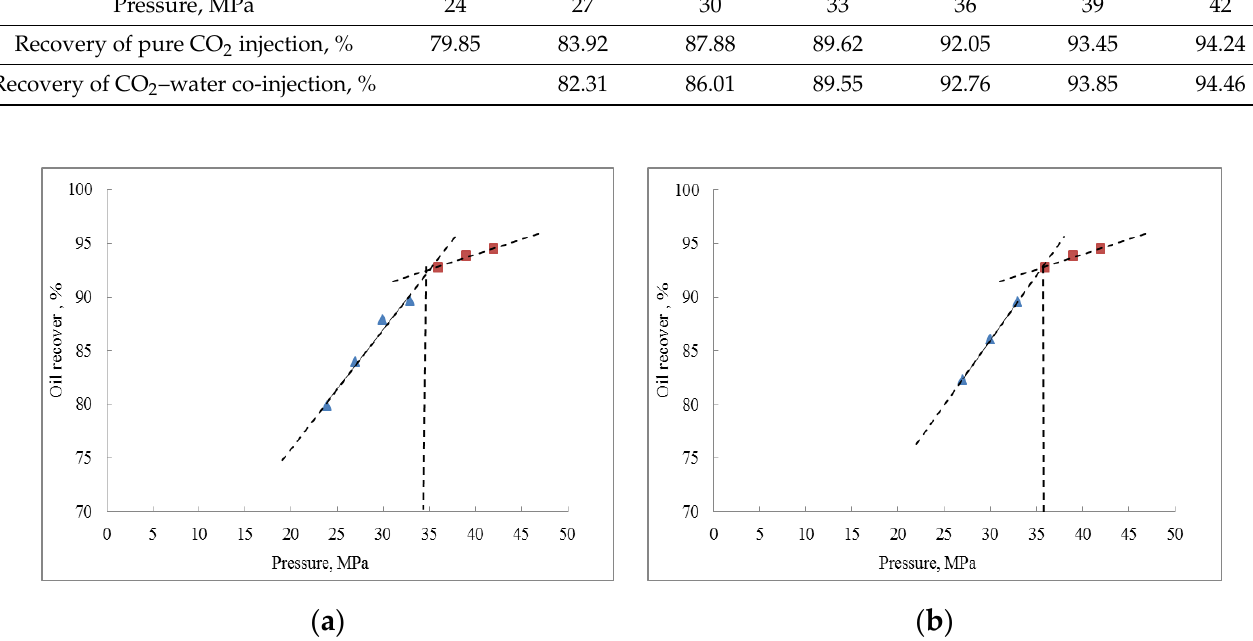
Figure 17. I The relationship between injection pressure and crude oil recovery: ( a ) pure CO 2 injection and ( b ) CO 2 –water